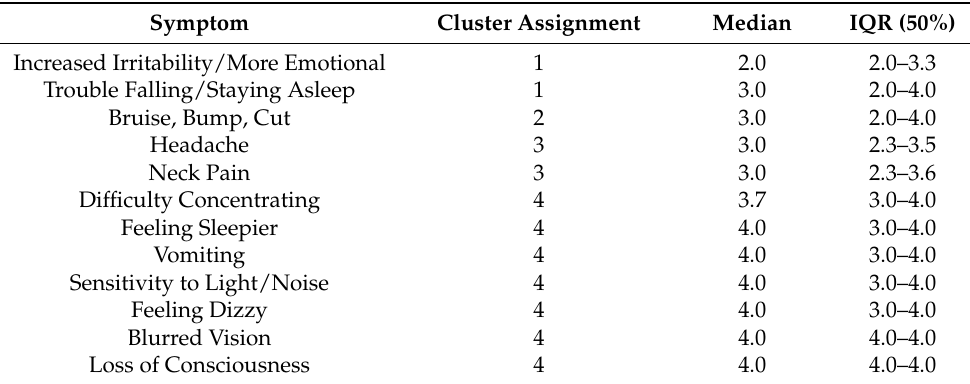
Table 3. Cluster assignments, median intention scores, and IQR (interquartile